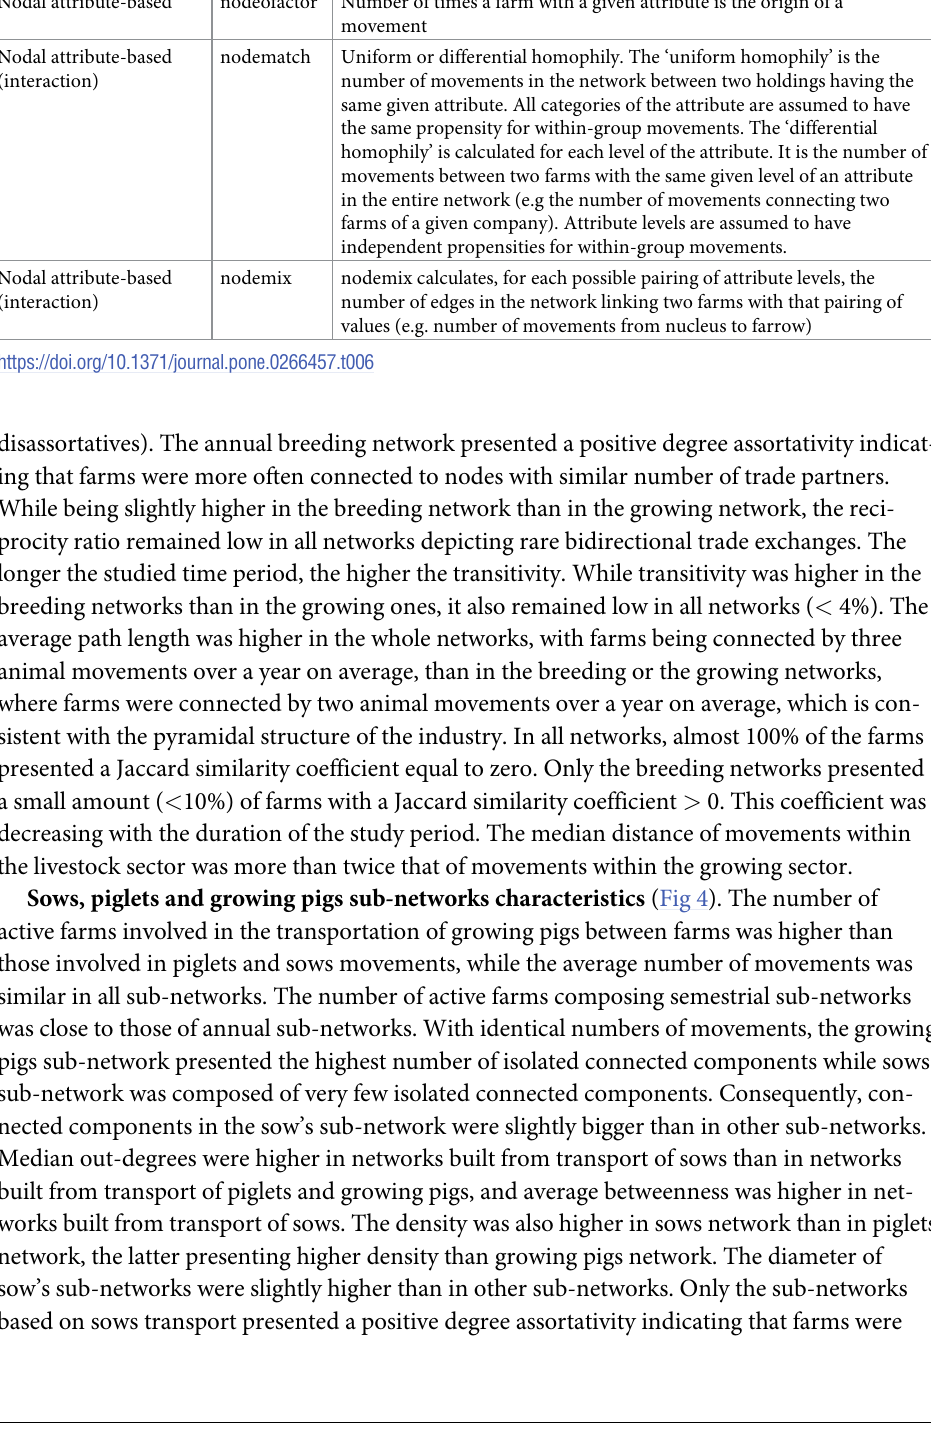
nodeofactor Number of times a farm with a given attribute is the origin of a movement Uniform or differential homophily. The ‘uniform homophily’ is the number of movements in the network between two holdings having the same given attribute. All categories of the attribute are assumed to have the same propensity for within-group movements. The ‘differential homophily’ is calculated for each level of the attribute. It is the number of movements between two farms with the same given level of an attribute in the entire network (e.g the number of movements connecting two farms of a given company). Attribute levels are assumed to have independent propensities for within-group movements. nodemix calculates, for each possible pairing of attribute levels, the number of edges in the network linking two farms with that pairing of values (e.g. number of movements from nucleus to